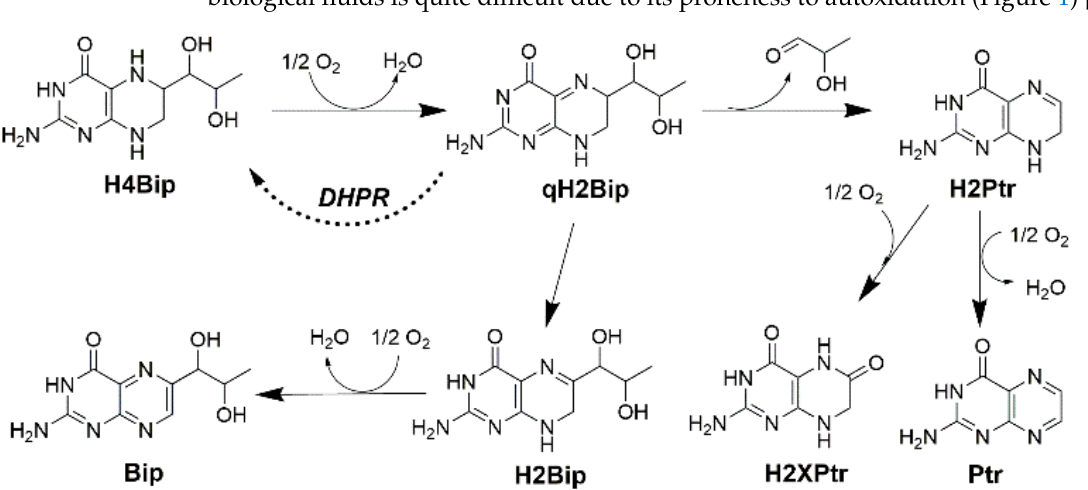
Figure 1. Autoxidation pathways of tetrahydrobiopterin (H4Bip) according to Refs. [2,18–23]. qH2Bipquinonoid dihydrobiopterin; H2Bip7,8-dihydro-biopetrin; H2Ptr—dihydro-pterin; H2XPtr—dihydro-xanthopterin; Bip—biopterin; Ptr—pterin; DHPR—dihydro-pteridine reductase.